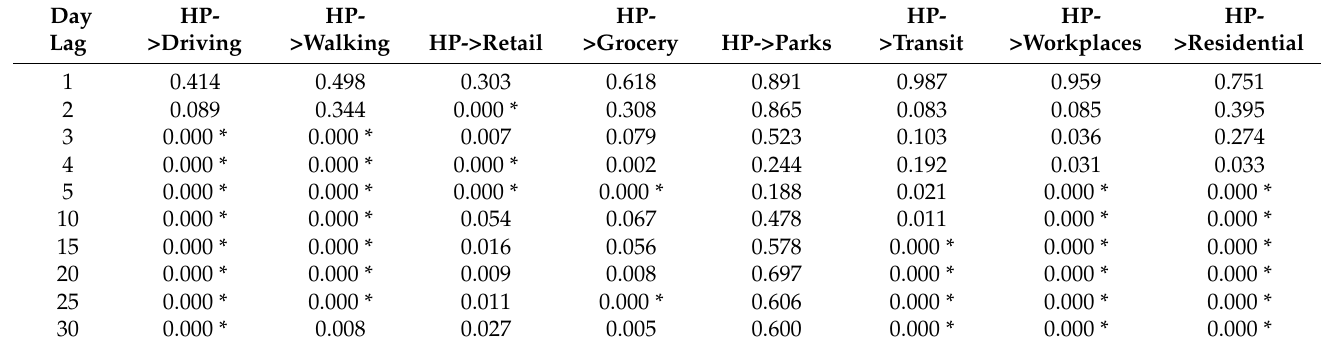
Table A16. Hosp_patients (HP), Granger-cause mobility variables, and p -values in day lags in